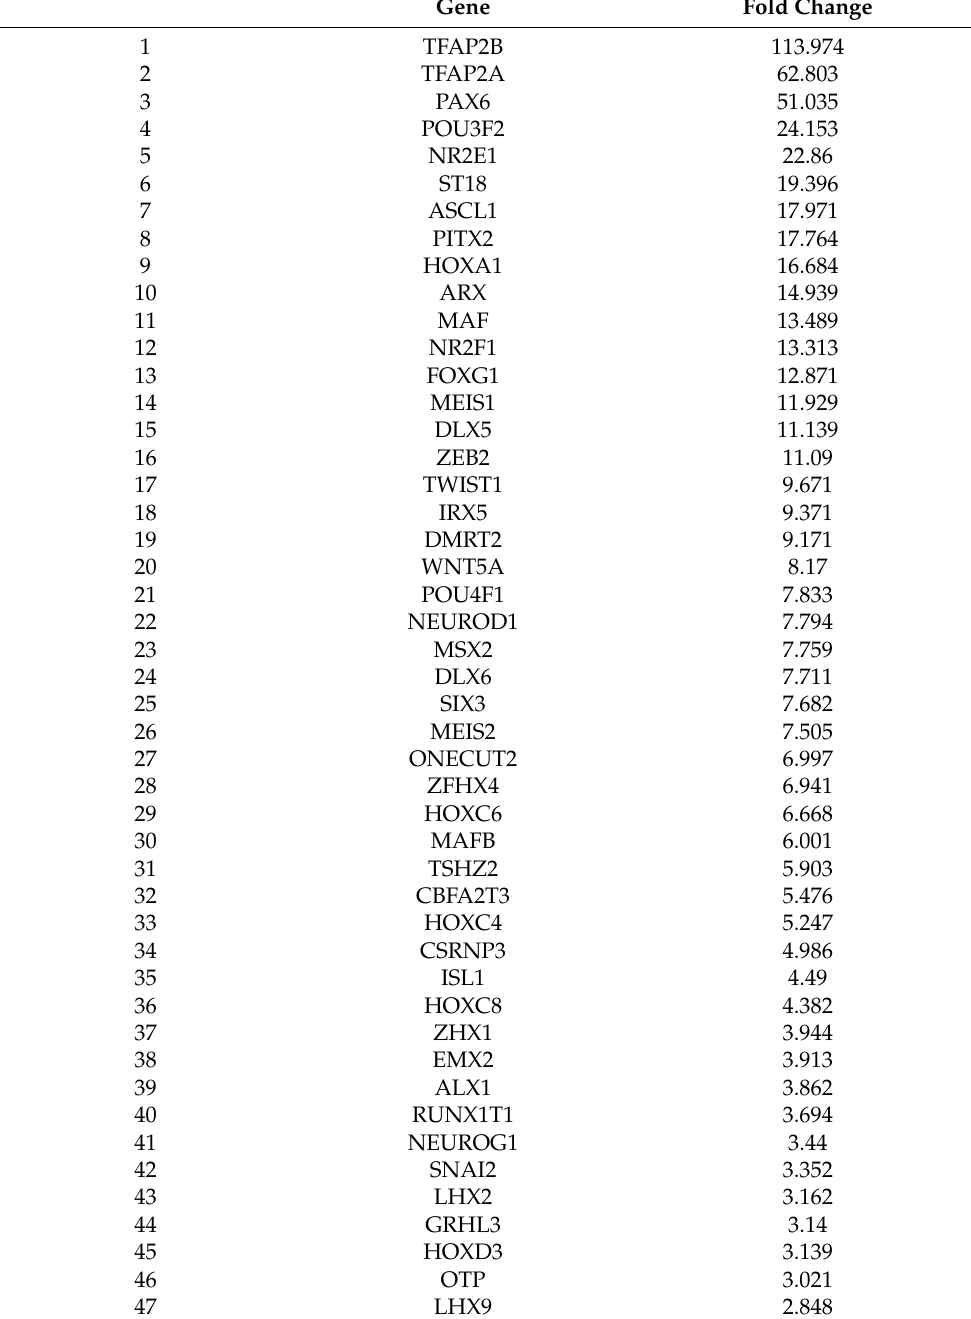
Table 6. Genes in transcription factor category that are upregulated in neural